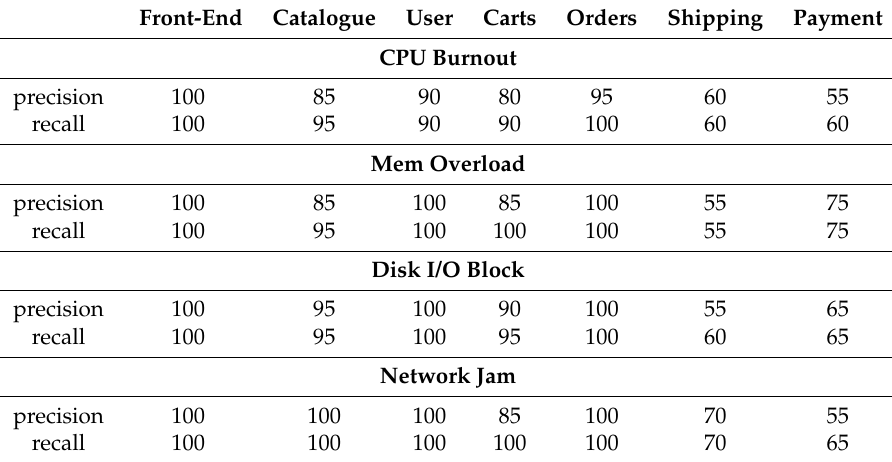
Table 2. Performance for different